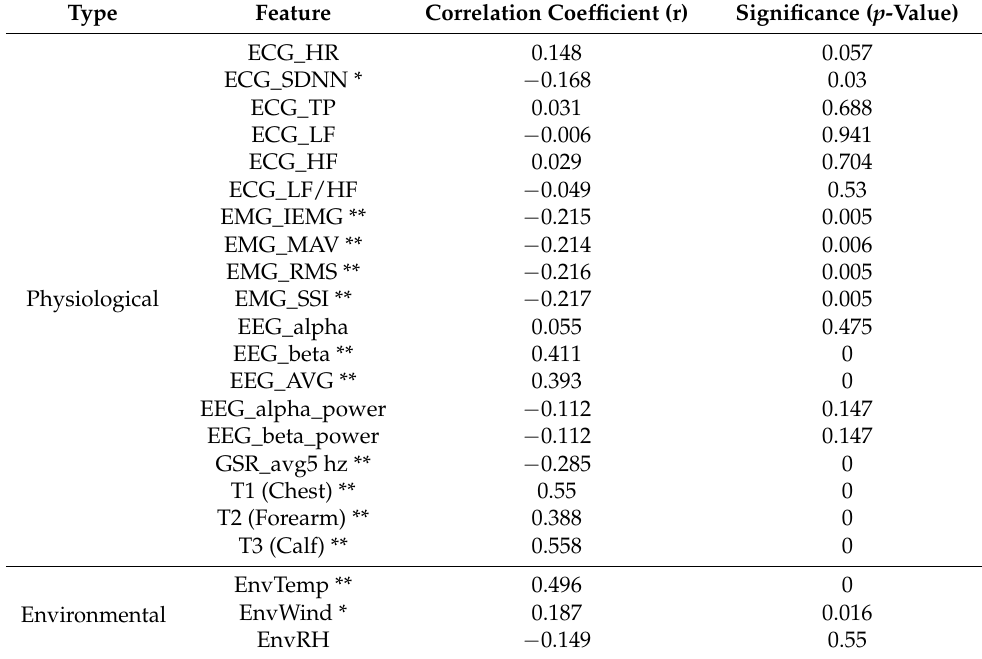
Table 2. Correlation coefficient between thermal sensation and each of the features.